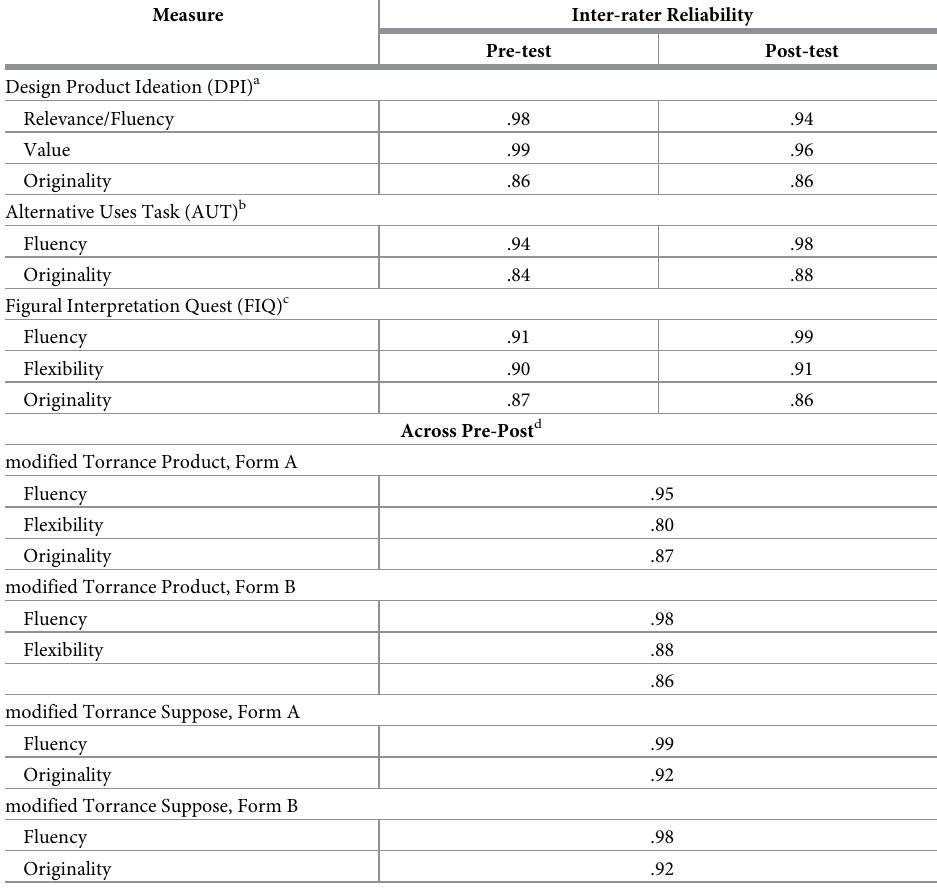
Table 3. Inter-rater reliability of the creative performance